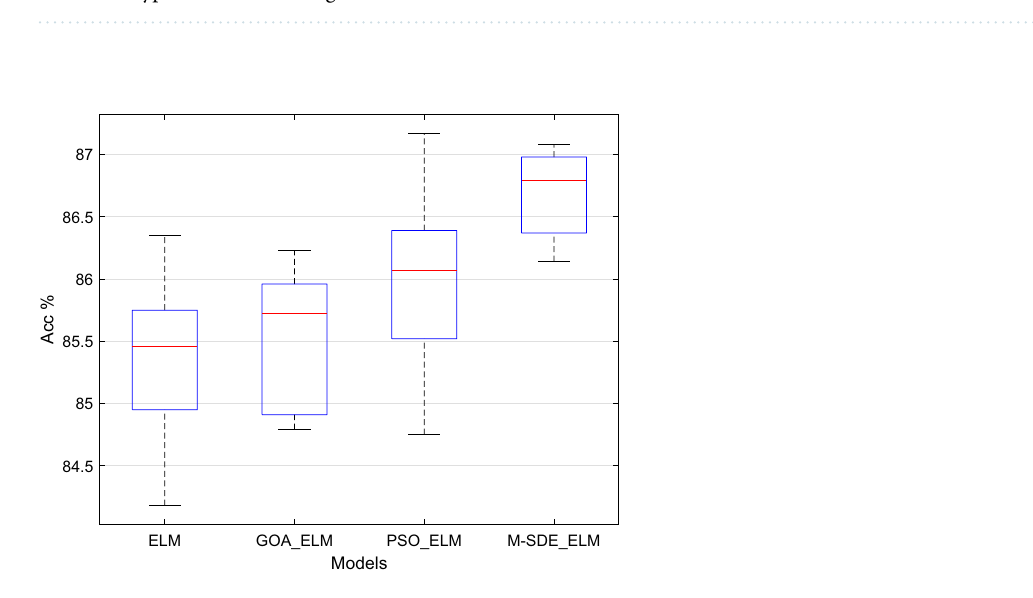
Figure 7. Single classifier experiments.